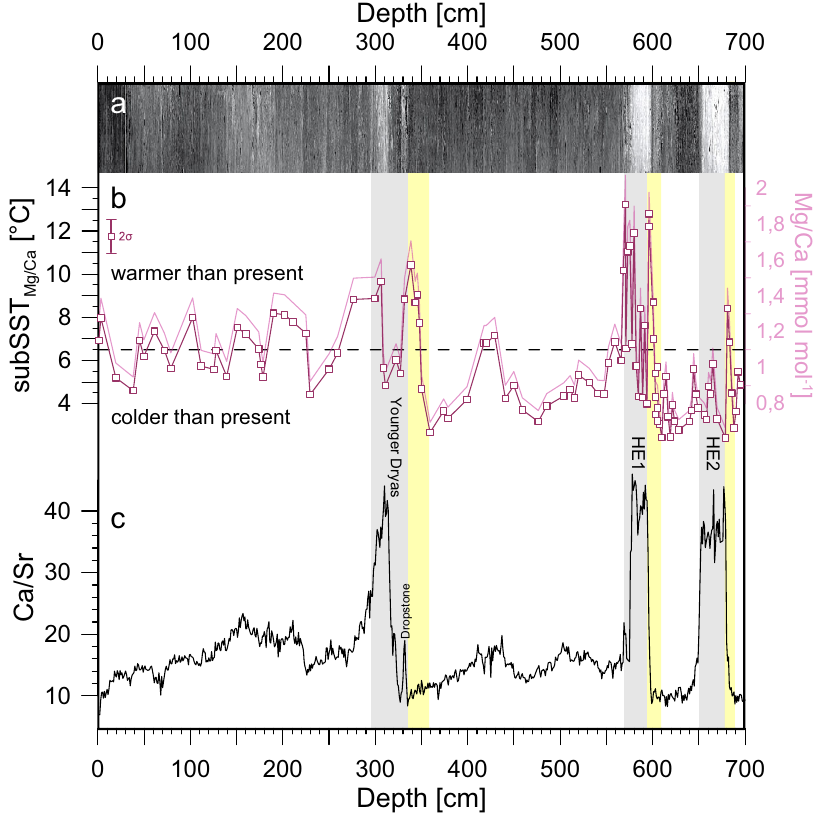
Fig. 2 Proxy records from sediment core GeoB18530-1 versus core depth in comparison to digital core image. a High-resolution digital core image 17 . b Foraminiferal Mg/Ca N. pachyderma sin. ratios and calculated subsurface temperatures (subSST Mg/Ca ) with analytical uncertainty (2 σ ). c X-ray fl uorescence scanning-derived calcium to strontium ratios (Ca/Sr). yellow bars = phases of increases in subSST Mg/Ca into Heinrich Events and the Younger Dryas; grey bars = Heinrich Layers (HE2 = Heinrich Event 2, HE1 = Heinrich Event 1) and the Younger Dryas. Dashed horizontal line in Fig. 1b indicates modern temperature at ~150 m water depth close to site GeoB18530-1 20